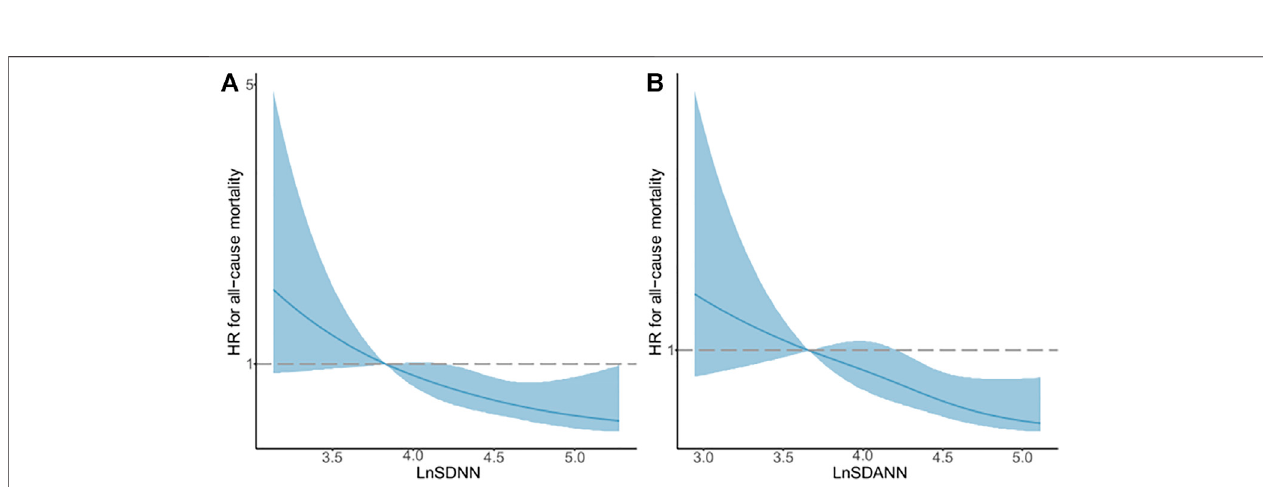
FIGURE 3 | Associations between LnSDNN/LnSDANN and All-cause Mortality Displayed by Restricted Cubic Spline Analysis in CKD5 Patients. (A) lnSDNN and all-causemortality. (B) lnSDANNandall-causemortality.Hazardratiosareindicatedbysolidbluelinesand95%con fi denceintervalsbyshadedareas.Referencelinesfor no association are indicated by dashed lines at a hazard ratio of 1.0. Abbreviations: SDNN, SD of normal-to-normal R-R intervals; SDANN, SD of 5-minute average of normal R-R intervals. CKD, chronic kidney disease.